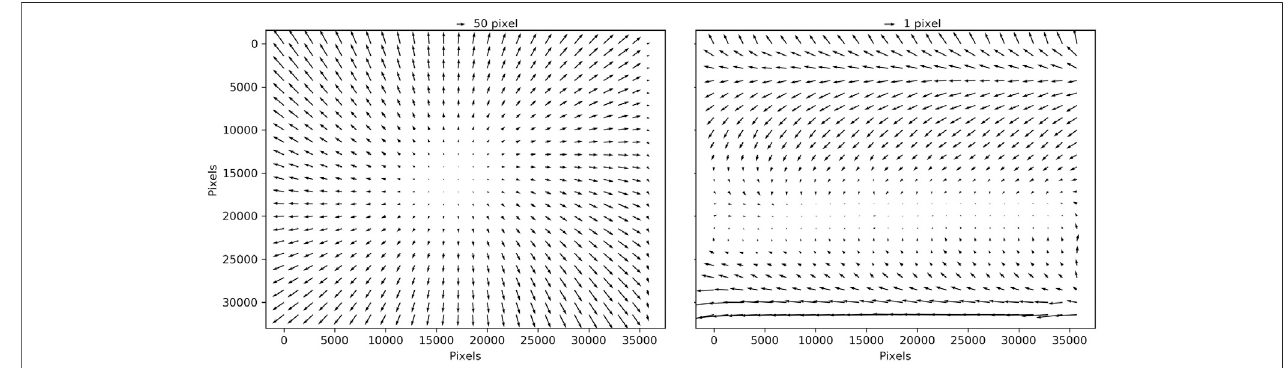
TABLE 1 | Estimated camera intrinsic parameters for each of the twelve KH-9 mapping cameras. Mission Number of